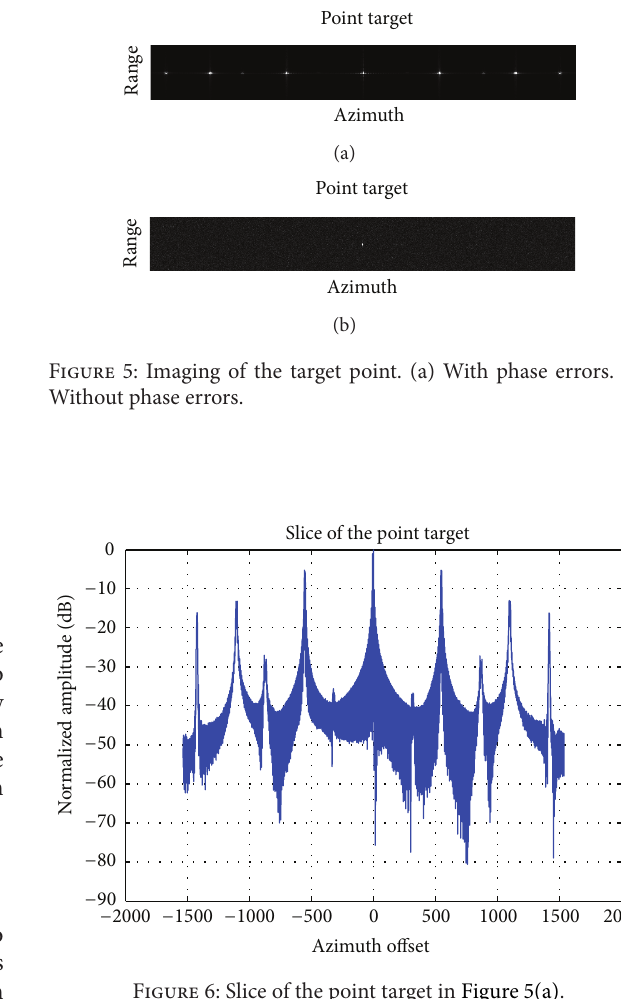
Figure 6: Slice of the point target in Figure